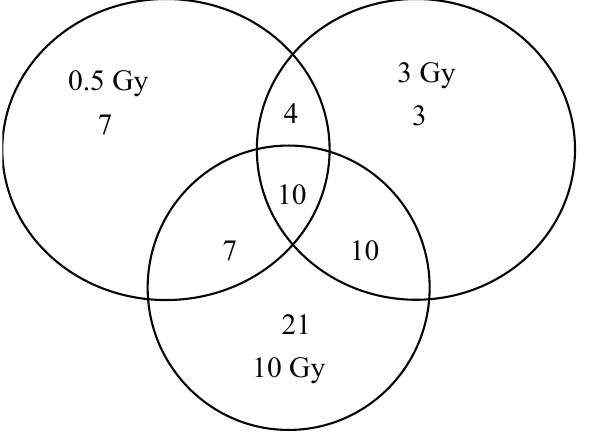
Figure 2. Venn diagram showing the overlap of genes with significant expression changes 24 h after exposure to different X-ray